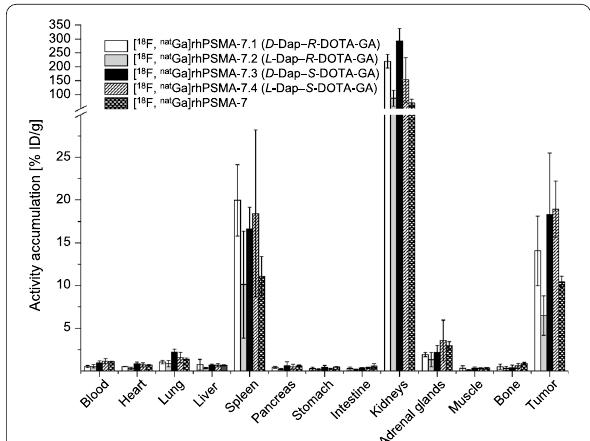
file 1: Table 3). As expected, the competition experiments resulted in highly efficient reduction of the uptake of respective isomers in kidneys, tumor, spleen and adrenal glands. Under competition, tumor uptake (0.9 0.2%ID/g ± to 1.5 0.4%ID/g) only marginally exceeded the ± activity concentrations in blood (0.6 0.1%ID/g to ± 1.1 0.3%ID/g) for all isomers. The normal kidney ± uptake (range: 88 29%ID/g to 292 45%ID/g) was also ± ± markedly lowered (range: 7 2%ID/g to 16 2%ID/g). ± ±